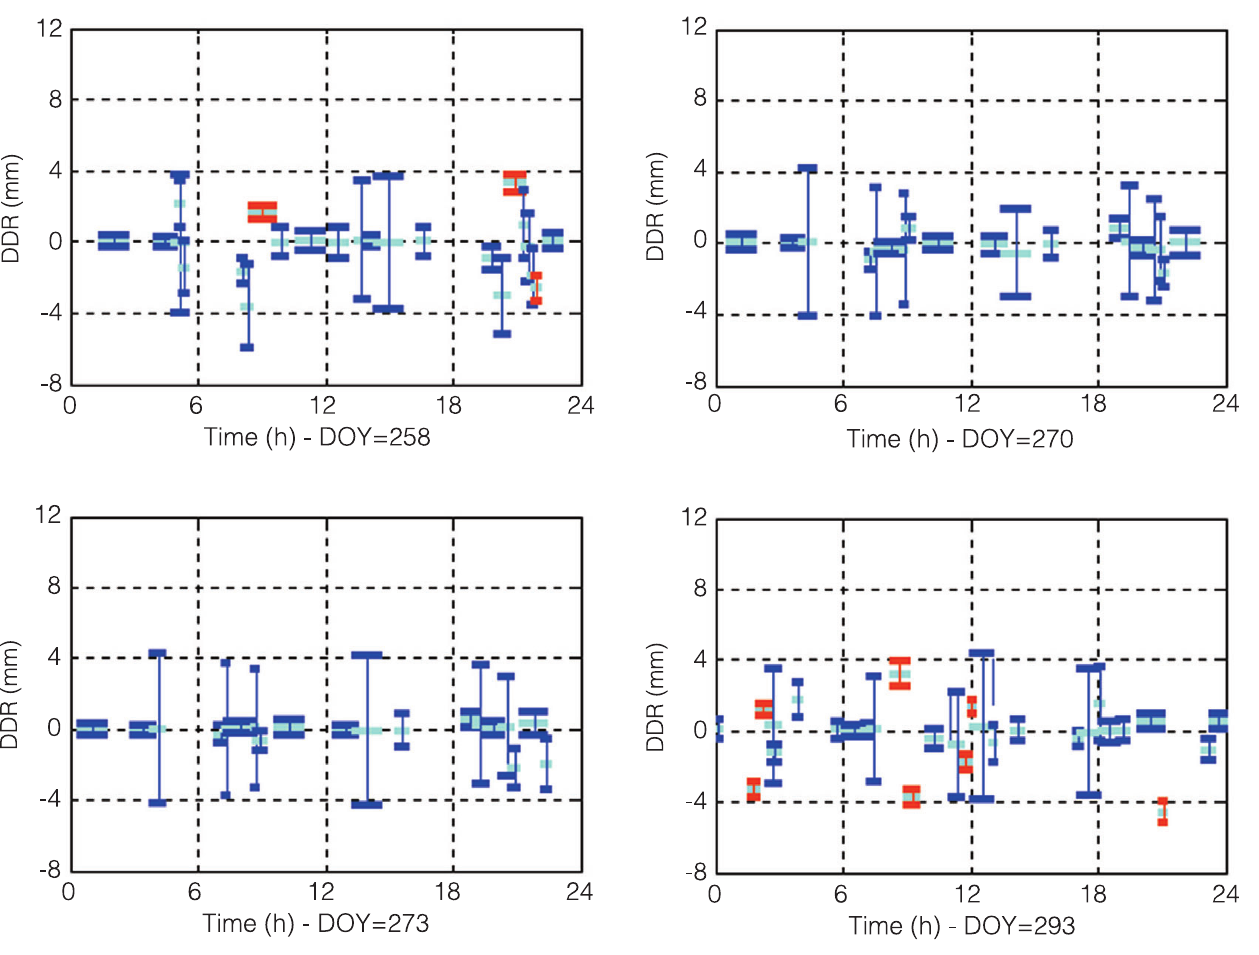
Fig. 2. Double differences residuals versus time for DOY: 258, 270, 273 and 293 of the year 1999 for the GPS stations Padua and Medicina (Italy). Lines: cyan-mean DDR; blue-standard deviation; red-anomalous